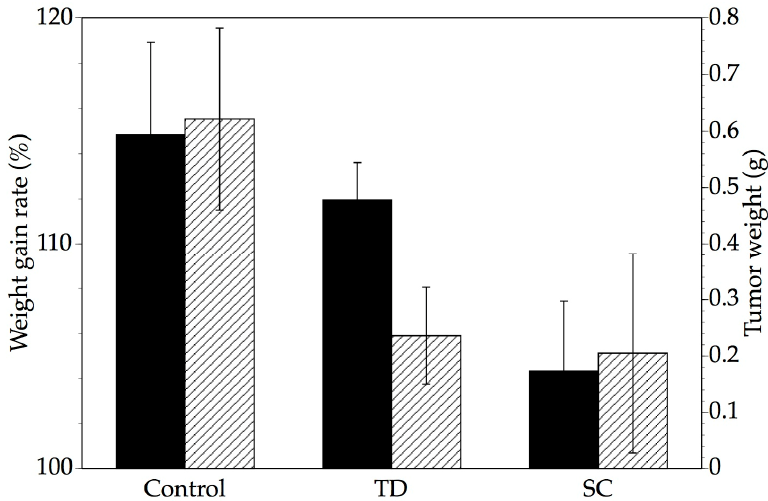
Figure 2. Comparison of transdermal and subcutaneous administration of adriamycin by weight gain rate and tumor weight. The body weight gain rate (black bars, left axis) and tumor weight (striped bars, right axis) of tumor-bearing mice transdermally administered (TD) and subcutaneously injected (SC) with adriamycin were compared ( n = 4). The daily transdermal administration and the once every three days subcutaneous injection of adriamycin resulted in similar anti-cancer effects, as estimated by the tumor weight. However, transdermal adriamycin administration led to a higher weight gain rate in mice than subcutaneous injection ( p < 0.05, Welch’s t -test), and was statistically similar to the level in the untreated control. Data are shown as the mean ± S.D..